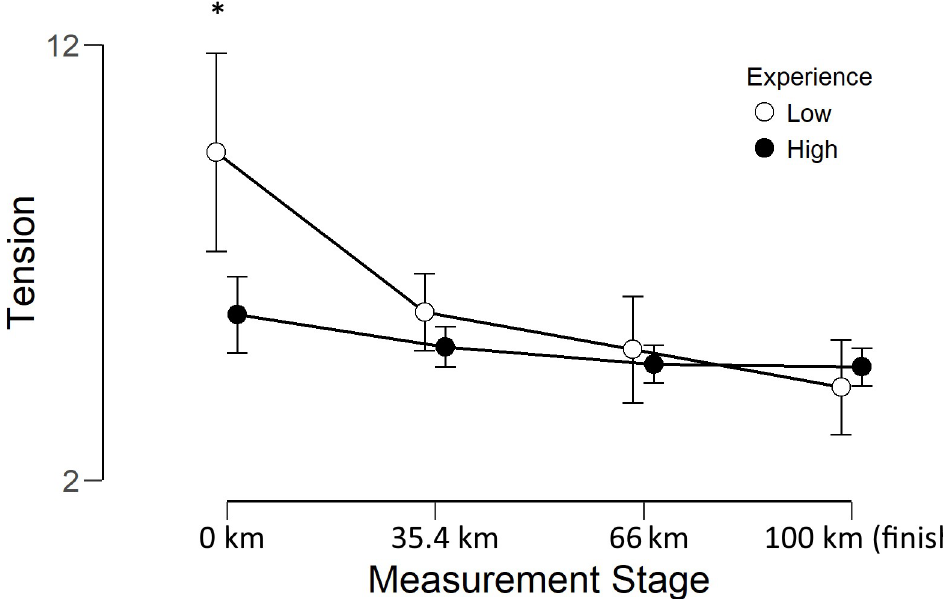
Fig 4. Tension scores for less experienced ( � ) and more experienced ( ● ) athletes at each measurement point. Error bars show 95% confidence intervals. � indicates a statistically significant